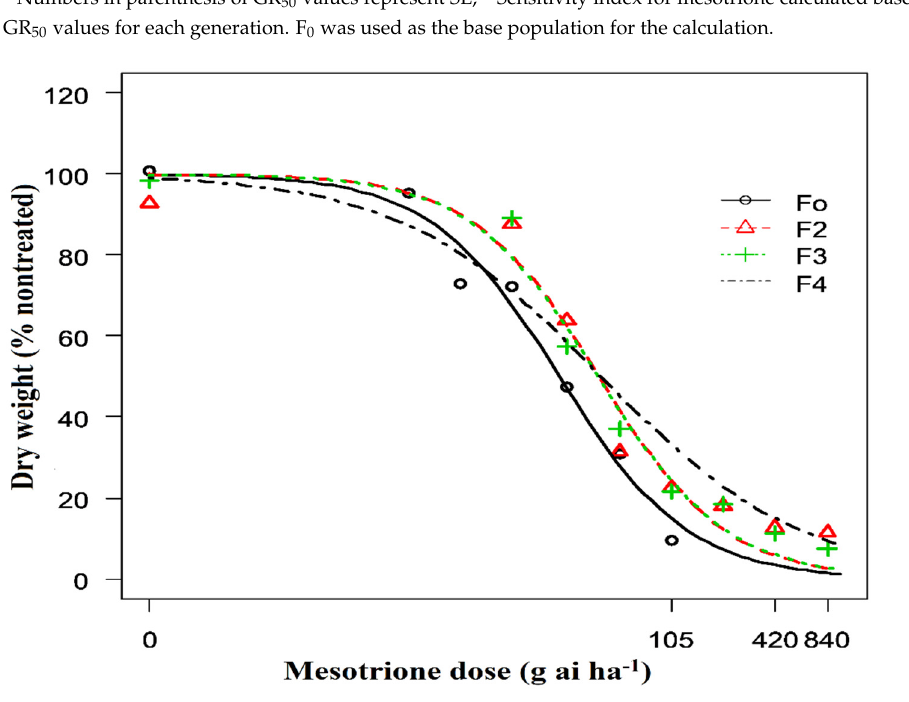
Figure 1. Generations of A. palmeri (F 1 , F 2 , F 3 , and F 4 ) treated with different mesotrione rates (x = 105 g ai ha − 1 ). Picture taken 3 weeks after treatment.